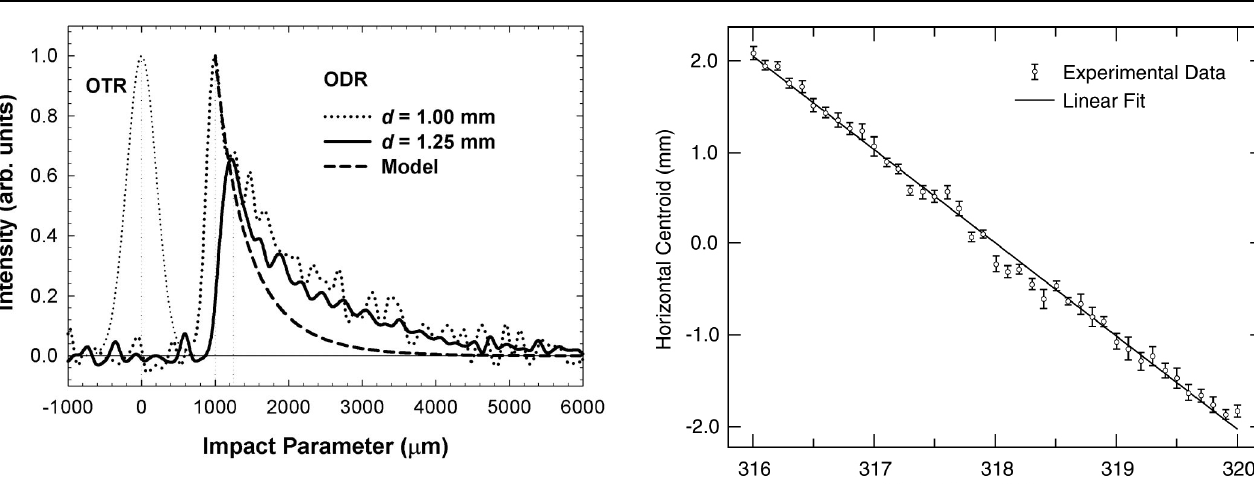
FIG. 7. Comparison plots of a Gaussian fit to the OTR beam (cid:5) 200 (cid:2) m centered at d (cid:5) 0 , the d (cid:5) 1000 distribution for (cid:5) y (dotted line) and 1250 (cid:2) m (solid line) ODR image vertical profiles, and the Eq. (1) model result (dashed line) scaled to the vertical profile